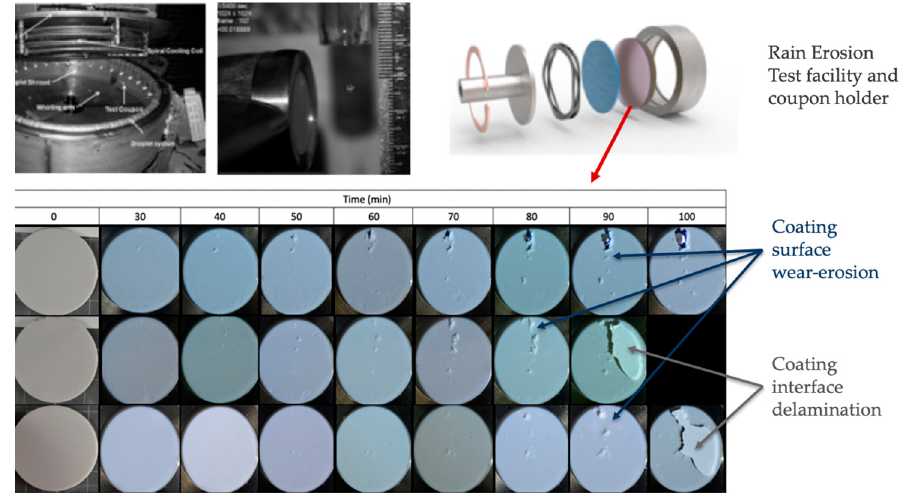
Figure 3. Two di ff erent types of erosion failure: Coating surface wear erosion with pits and cracks that progress with mass loss caused by direct impact and stress on surface and coating interface delamination indirectly caused by the coating-substrate interface stresses. The coupons were tested at Whirling arm rain erosion test facility (WARER) at University of Limerick.